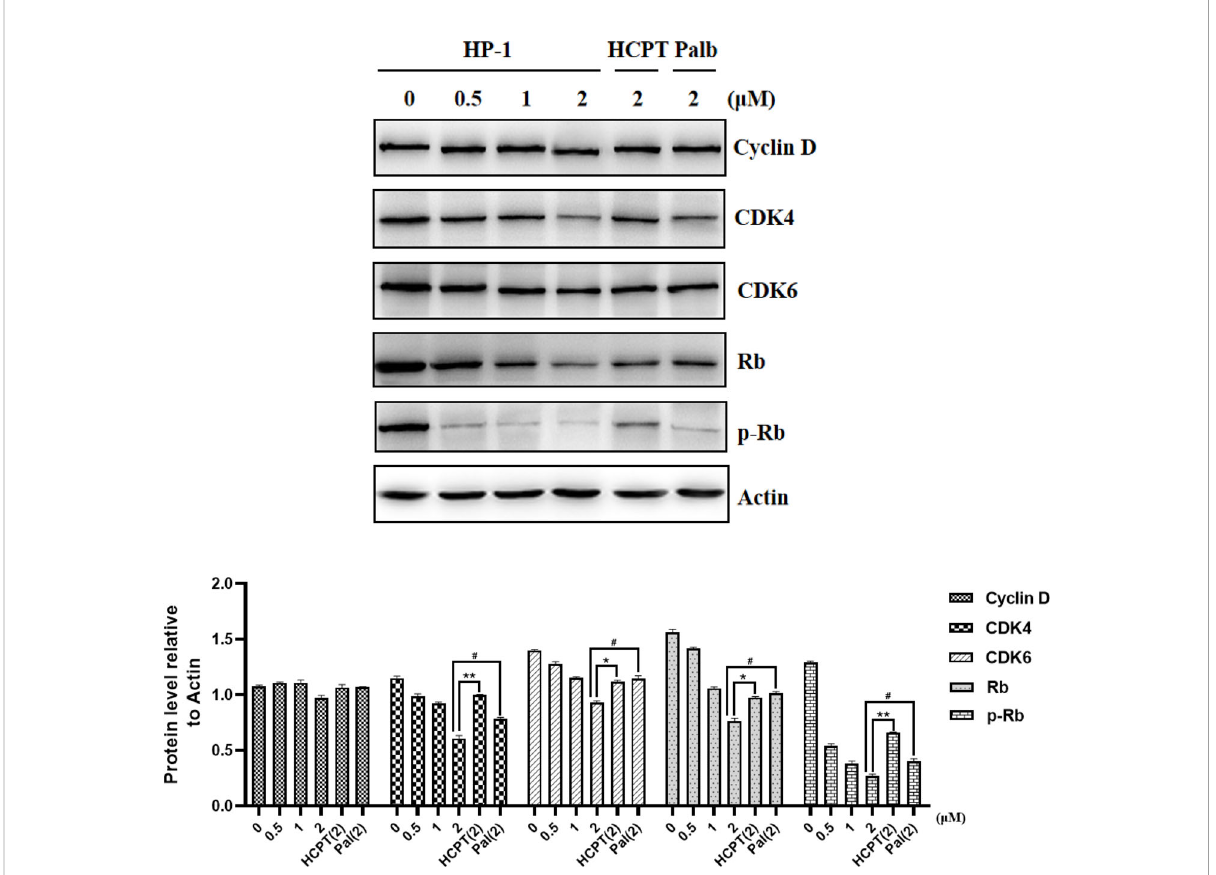
FIGURE 7 Effect of HP-1 on Cyclin D-CDK4/6-Rb-2F pathway proteins of NCI-H460 cells. Data shown are the mean ± SEM of three independent experiments (* p <0.05, ** p <0.01, compared to HCPT; # p <0.05, compared to